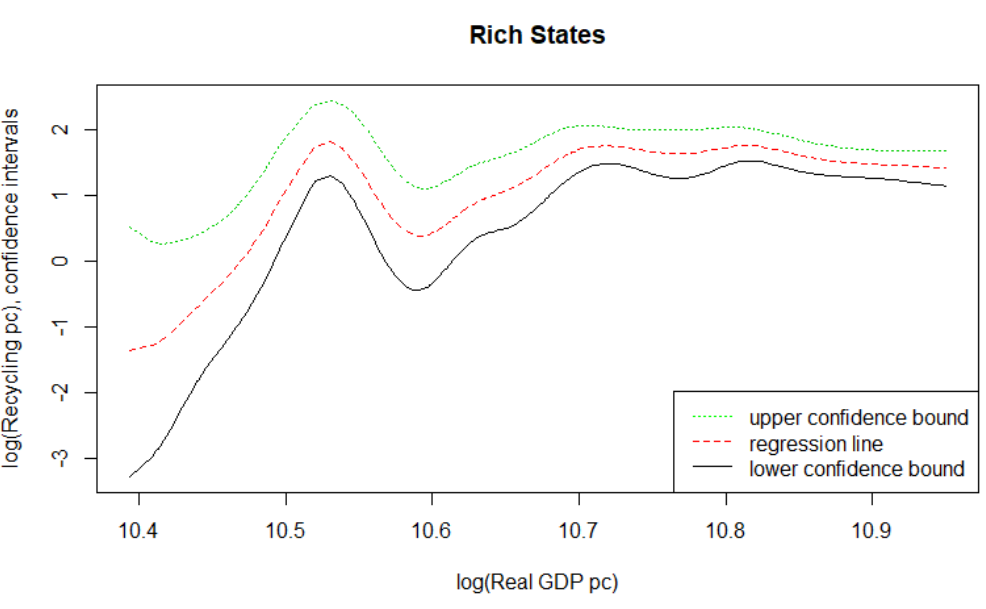
Figure 2. Relationship between log of Recycling per capita and log of Real GDP per capita for rich